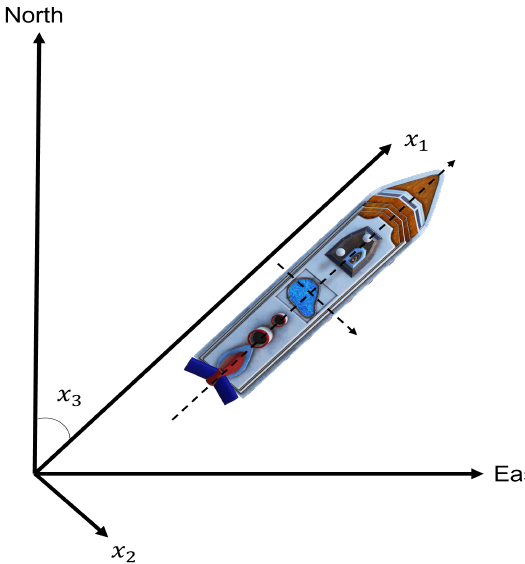
Figure 3: The figure is illustrating the NED and Body coordinate